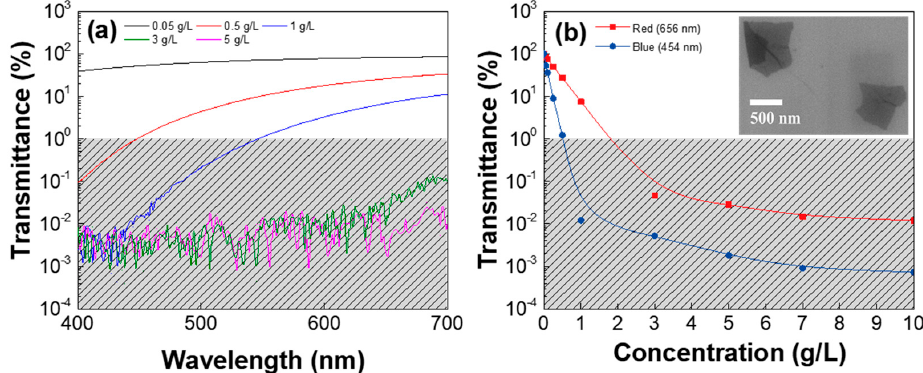
Figure 1. Transmittance of different GSes ( a ) as a function of wavelength and ( b ) as a function of graphene oxide (GO) concentration in the graphene oxide solution (GS) at 454- and 656-nm wavelengths. The inset shows a typical scanning electron microscope (SEM) image of the GO flakes on the SiO 2 /Si wafer.